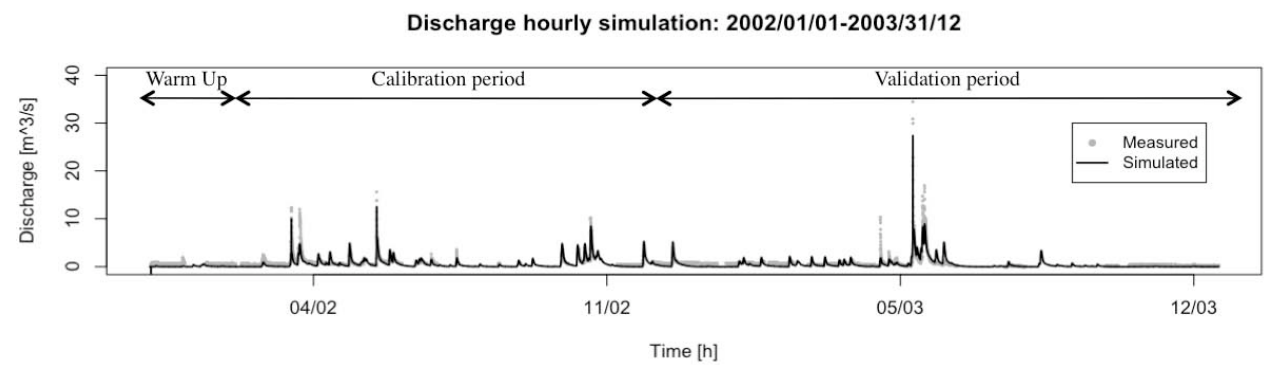
Fig. 7. Test A: application of the JGrass-NewAge model for the period 01/01/2002 to 31/12/2003: the solid curve represents the simulated discharge, while the dots represents the measured one.